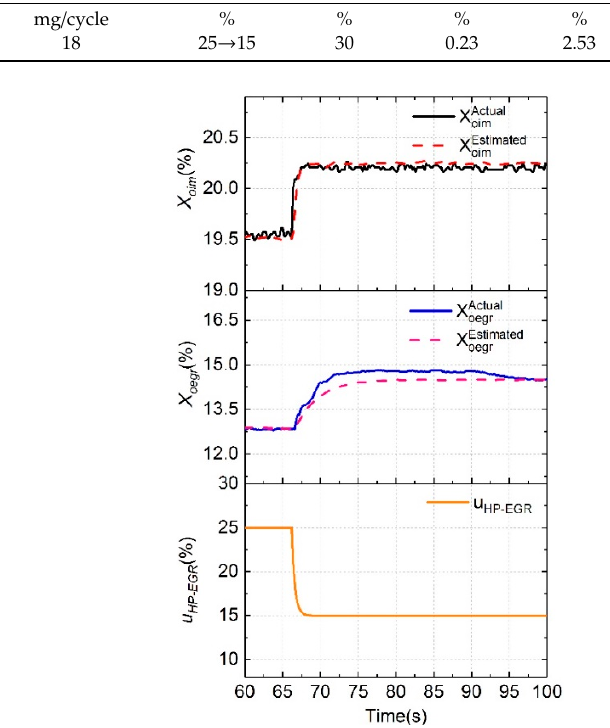
Figure A1. Experimental validation of oxygen concentration observer.